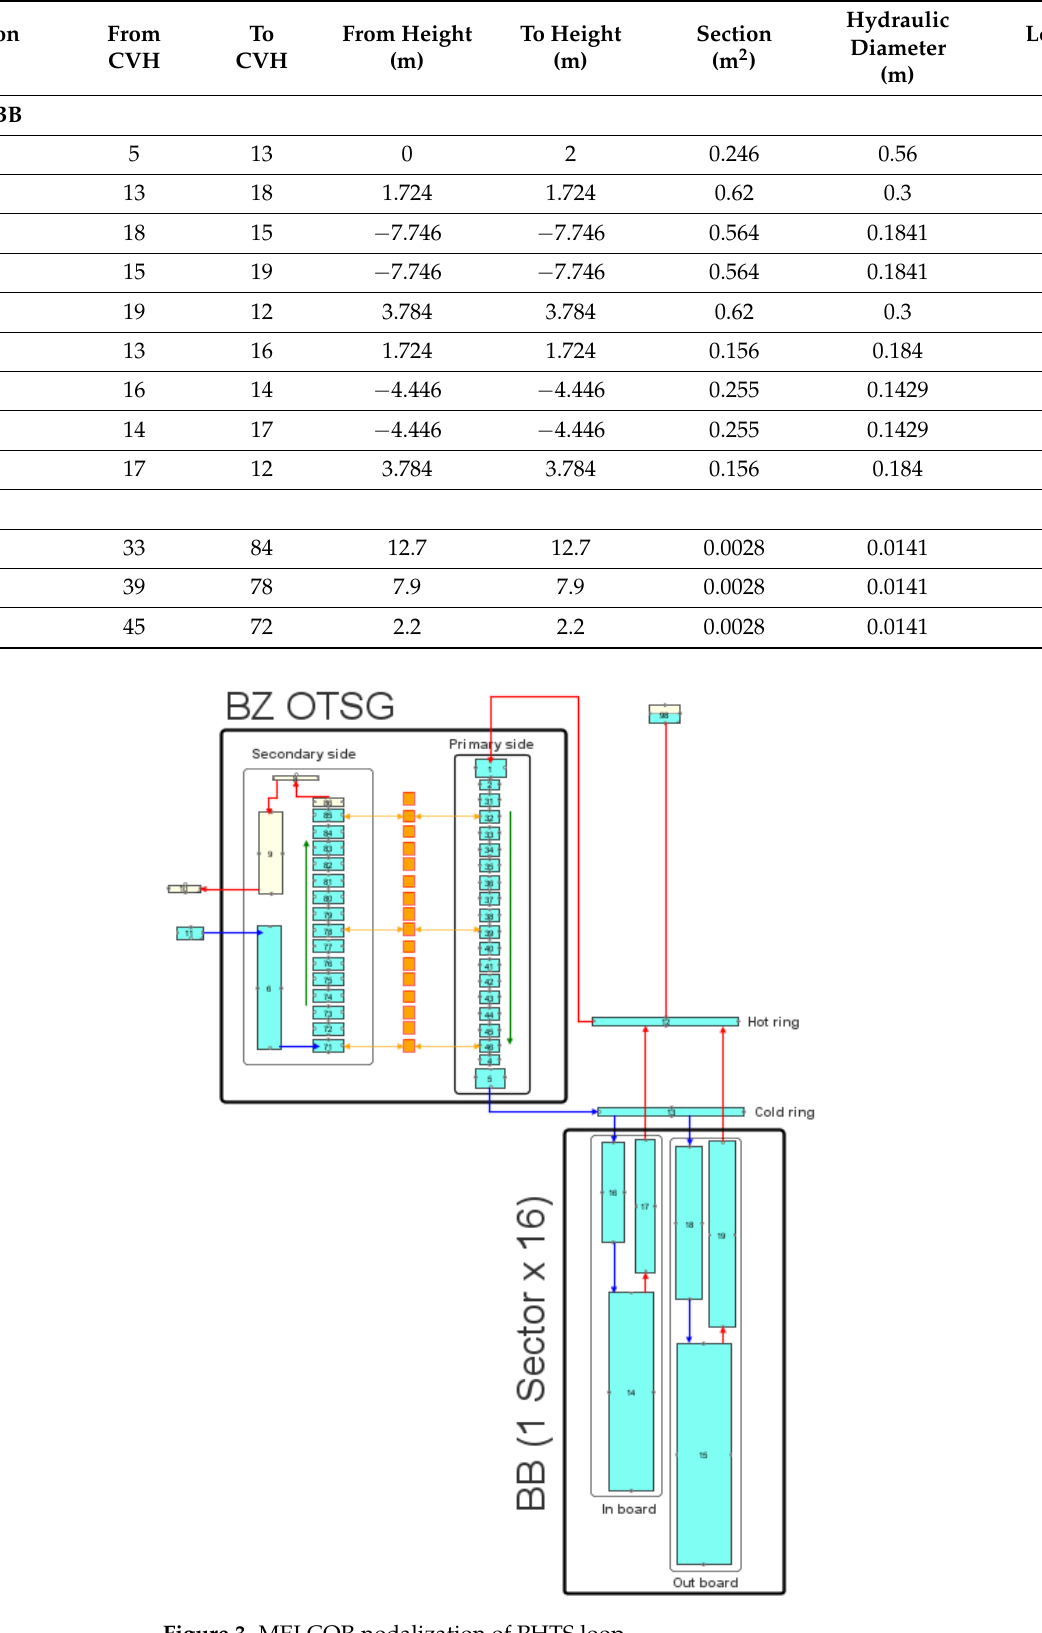
Figure 3. MELCOR nodalization of PHTS loop.